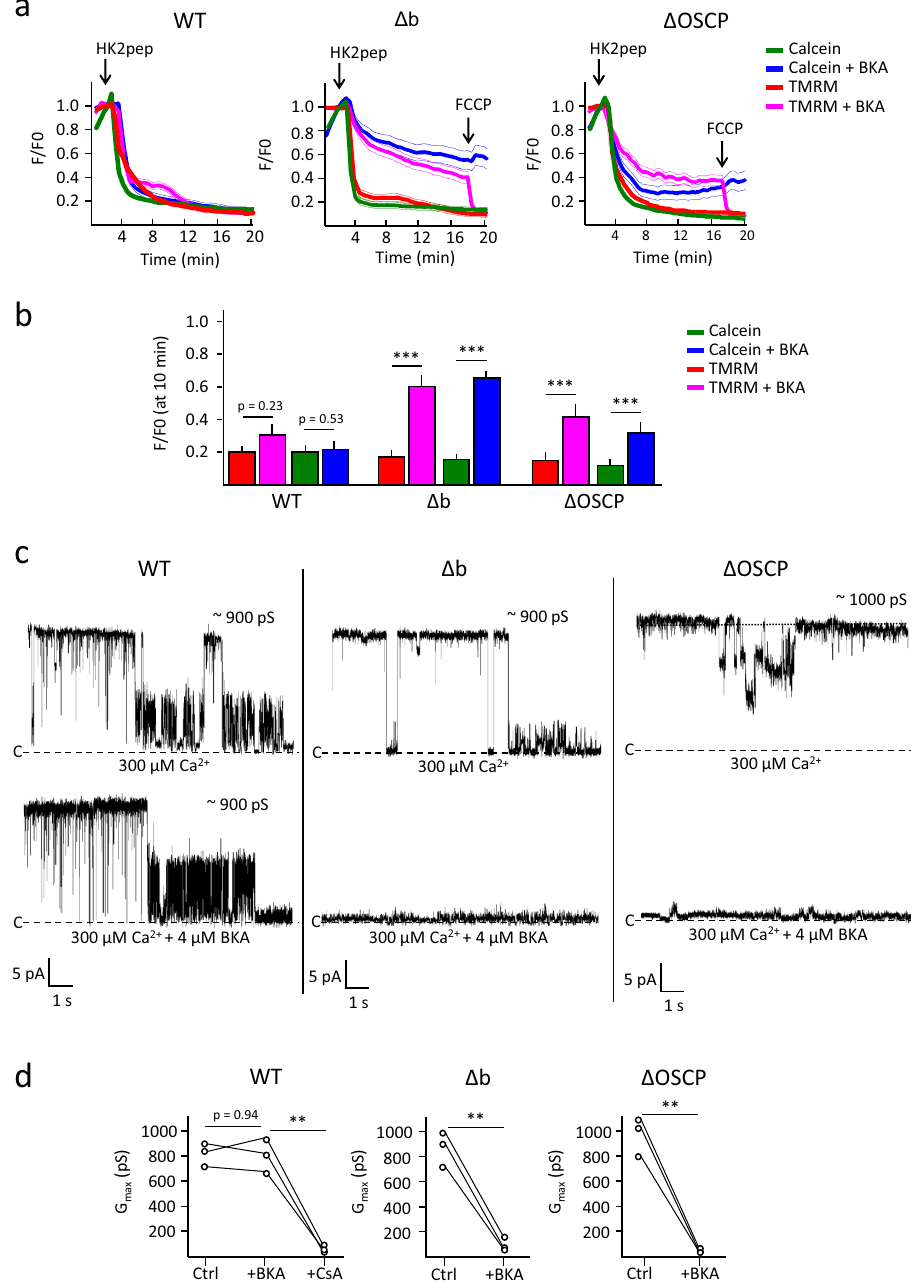
Fig. 4 Contribution of ANT channel activity to the occurrence of the permeability transition in cells lacking subunits b and OSCP. a Changes in mitochondrial calcein (green and blue traces) and TMRM (red and purple traces) fl uorescence intensities in the absence (green and red) or presence (blue and purple) of 4 µ M BKA. Where indicated, 15 µ M HK2 peptide (pep) was added. Data are averages of the following ROIs over three independent experiments for each condition and genotype: for WT, 87 (HK2) and 74 (HK2 + BKA); for Δ b, 65 (HK2) and 90 (HK2 + BKA); and for Δ OSCP 70 (HK2) and 97 (HK2 + BKA); SEM for each time point is denoted by thin lines. b Analysis of the calcein and TMRM fl uorescence intensities 8 min after peptide addition in the absence (green and red) or presence (blue and purple) of 4 µ M BKA. Data are average ± SEM of the ROIs indicated above, *** p < 0.001, ** p < 0.01, two-sided Student ’ s t -test. c Channel activity obtained by patch-clamping isolated mitoplast from WT HAP1 cells (left panel), HAP1- Δ b cells (middle panel) and HAP1- Δ OSCP cells (right panel). Where indicated, 4 µ M BKA was added. Representative currents are from three independent experiments. d Analysis of the maximal conductance ( G max ) calculated in each independent experiment before and after the addition of 4 µ M BKA or 4 µ M CsA. *** p < 0.001, ** p < 0.01, two-sided paired t